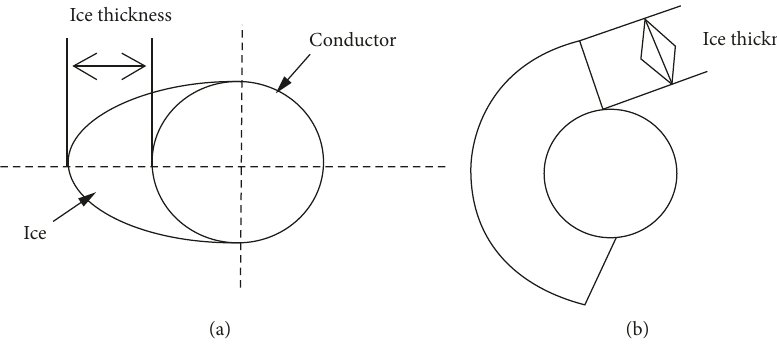
Figure 1: Cross section of iced model: (a) crescent and (b) sector.